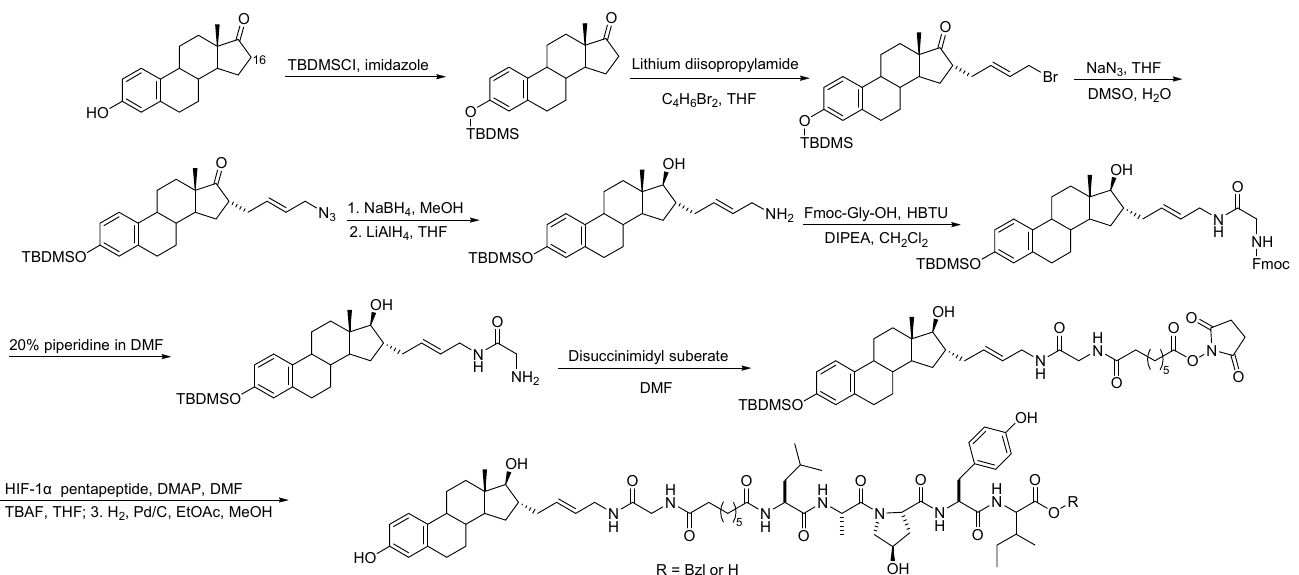
Scheme 1. Synthesis of C16-derivatized estradiol–based PROTAC.